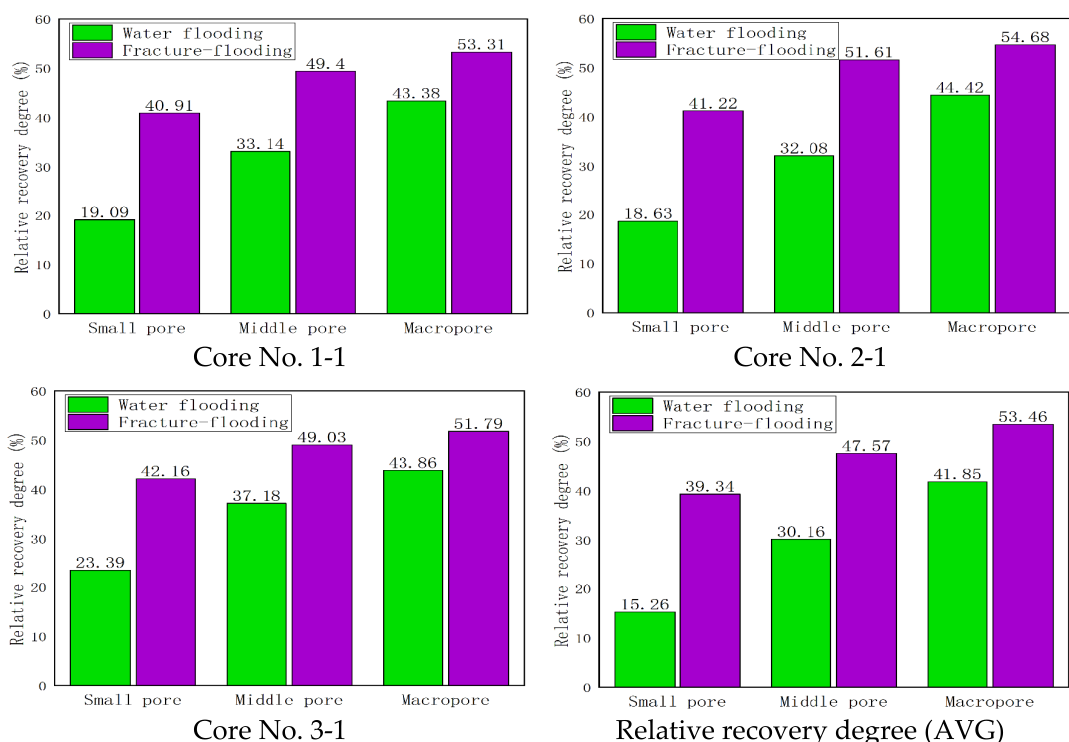
Figure 6. Relative recovery degree under different displacement conditions.